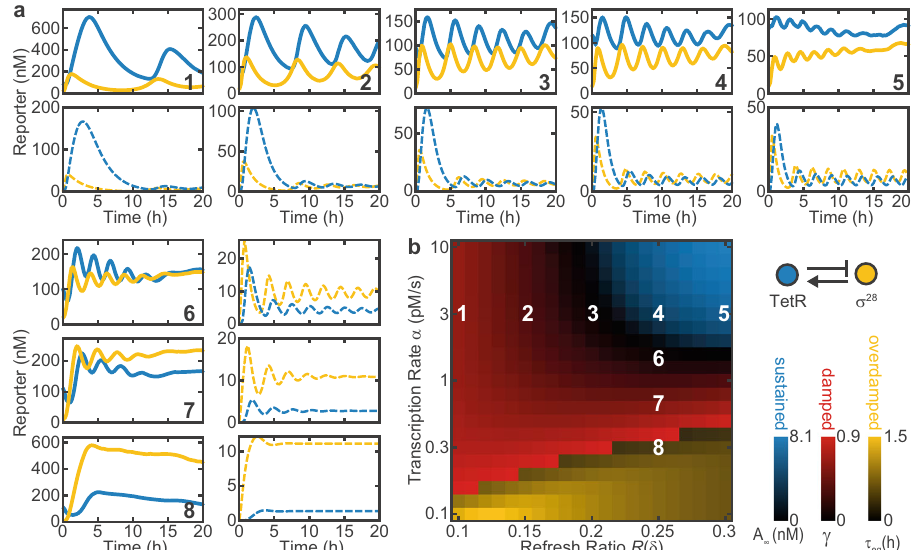
Fig. 2 Dynamics and phase diagram of the free oscillator. a Experimental (full) and simulated (dashed) time traces of the free oscillator for different refresh ratios R ( δ ) and DNA concentrations as indicated in b . b Simulated phase diagram of the free oscillator. Color overlay of different metrics as indicated in the legend reveals regions of sustained, damped and overdamped oscillations. A ∞ , γ , and τ eq are the normalized equilibrium amplitude, damping ratio, and equilibration time constant for trajectories with less than one detectable maximum, respectively. Experimental data were mapped onto the diagram using α as a fi tting parameter proportional to the DNA concentration. System parameters: n = 3, K a = 20 nM, K h = 2 nM, k TL = 0.02 s − 1 , τ ¼ 12min. DNA concentrations are 0.1 – 1 nM ( α = 0.3 – 3 pMs − 1 ) for the circuit plasmids and 2 nM for reporter m